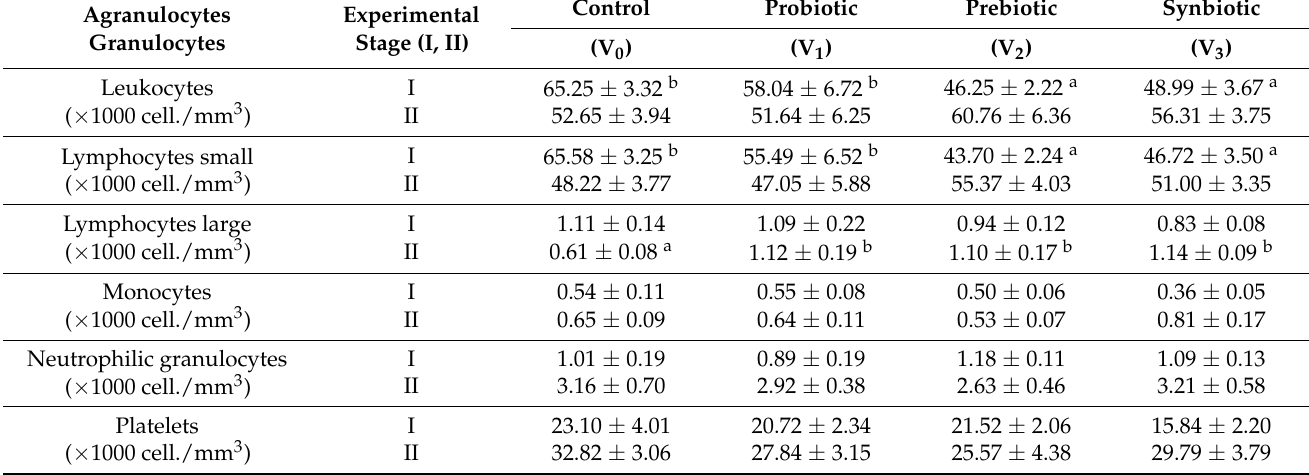
Table 3. Variation of the absolute number of leukocytes and platelets in Nile tilapia in the two experimental stages.